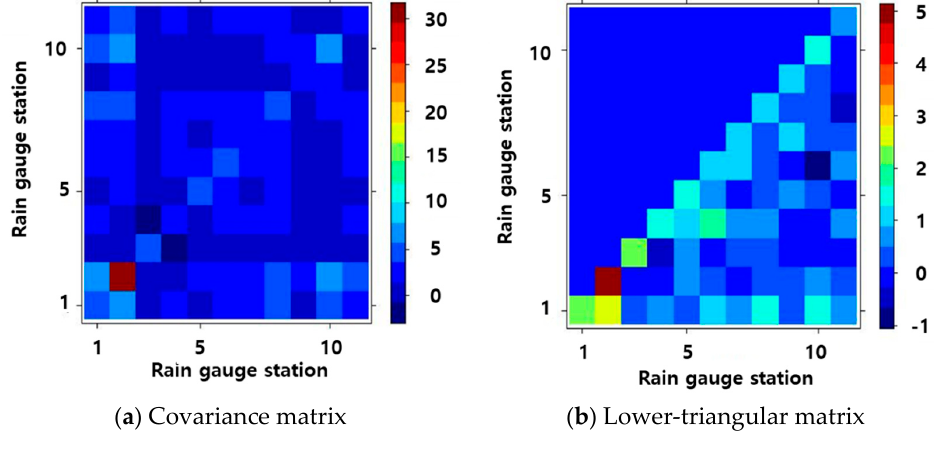
Figure 6. Covariance matrix and lower-triangular matrix.